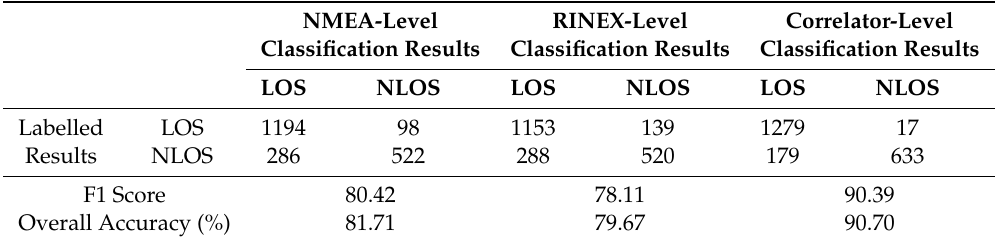
Table 3. Performances of the different algorithms (extracted from [63]). NMEA, National Marine Electronics Association; RINEX, Receiver Independent Exchange